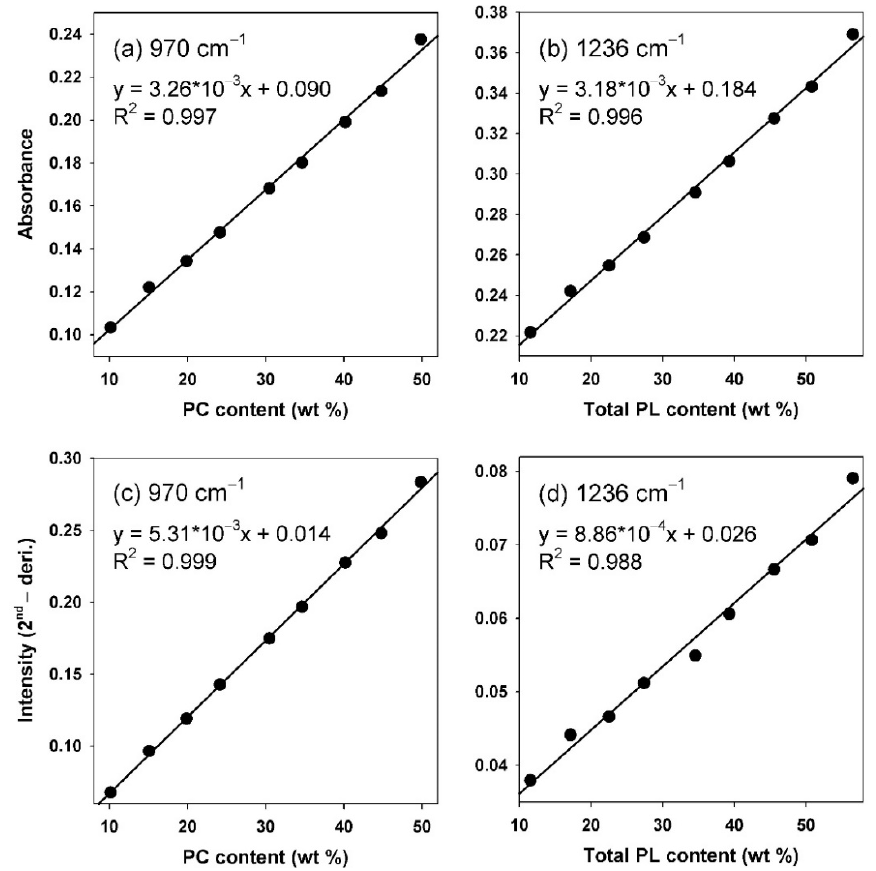
Figure 3. Calibration curves for PC and total PL content: absorbance and its second-derivative of ( a , c ) (CH 3 ) 3 -N-asymmetric stretching (970 cm − 1 ) signal and ( b , d ) -P=O asymmetric stretching (1236 cm − 1 ) signal.